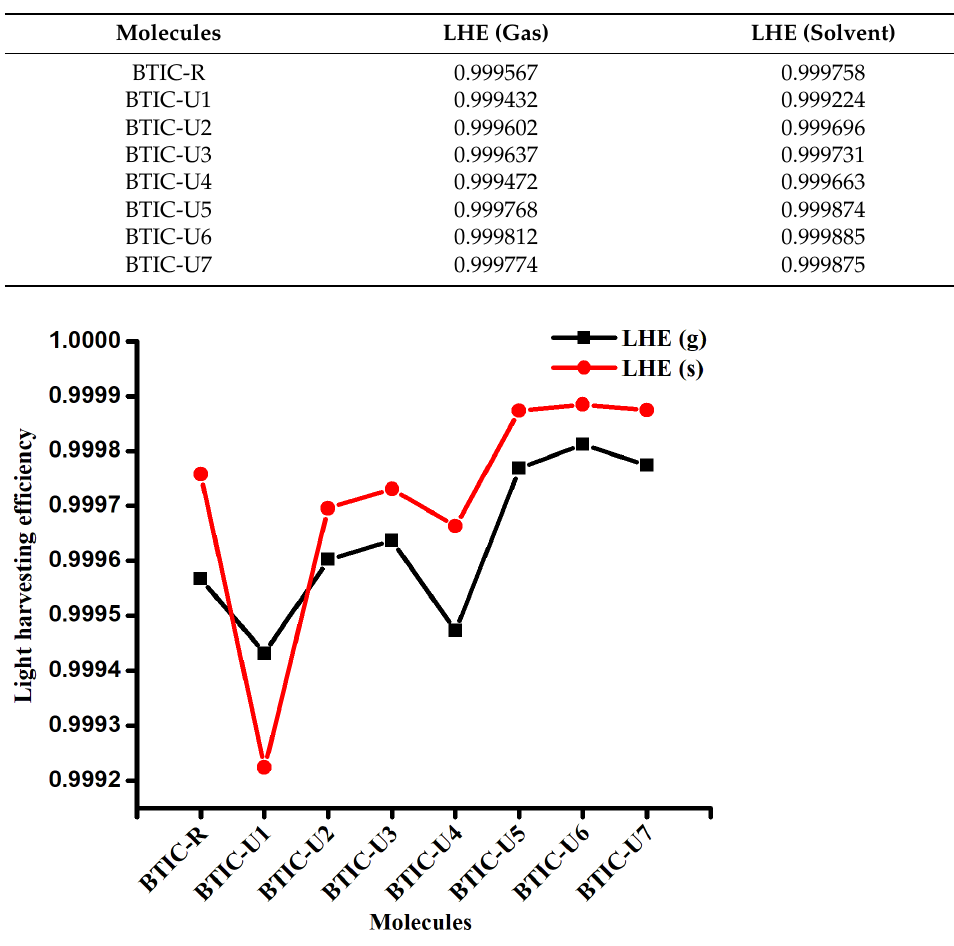
Figure 5. Light harvesting efficacy for BTIC-R to BTIC-U7 molecules in gas phase and in solvent.